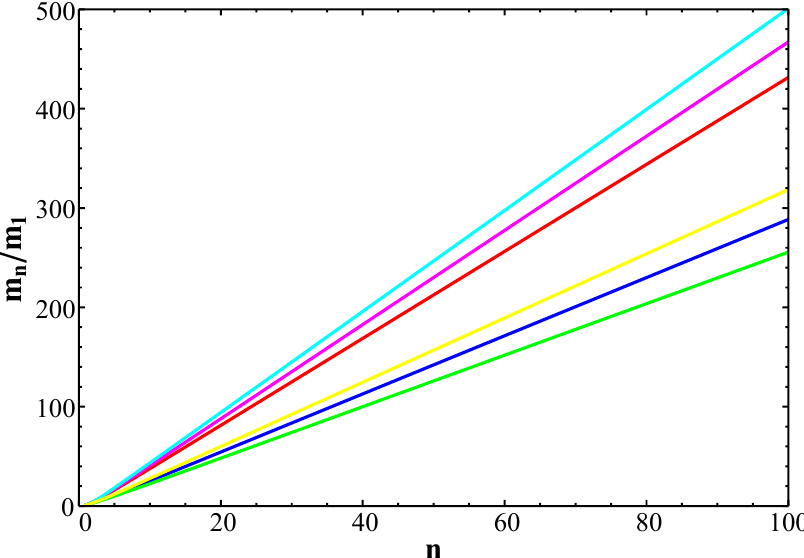
Figure 4 . Approximate linear growth of the relative dark photon KK mass ratio m n /m 1 as a function of n for various choices of ( τ, a F ) =(1/2,1/2) [red], (1/2,1) [blue], (1/2,3/2) [green], (1,1/2) [magenta], (3/2,1/2) [cyan] and (1,1) [yellow],